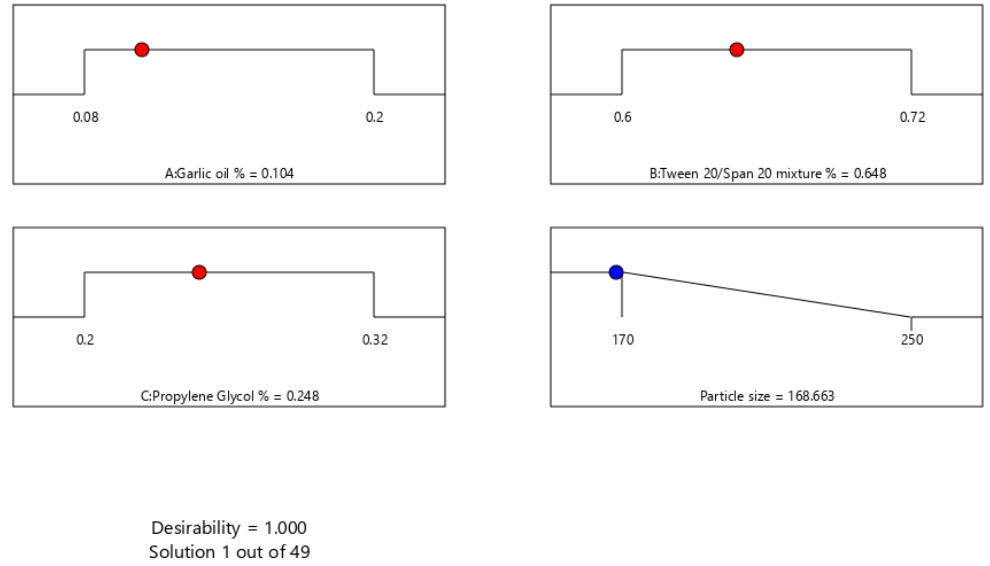
Figure 4. Desirability values of the numerical optimization process for ACV-GO SNEDDS through statistical design opti- mization.